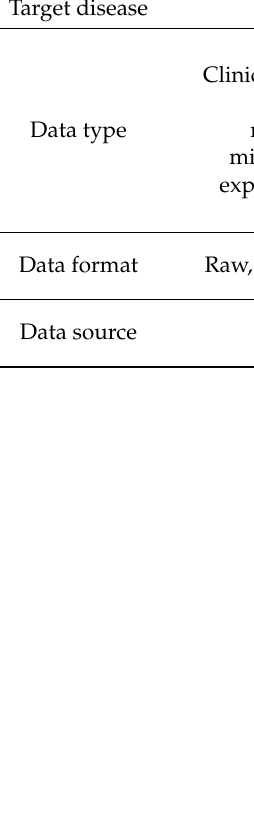
Table 5. Comparison of epigenomic data sources used for training predictive models for translational epigenomics.